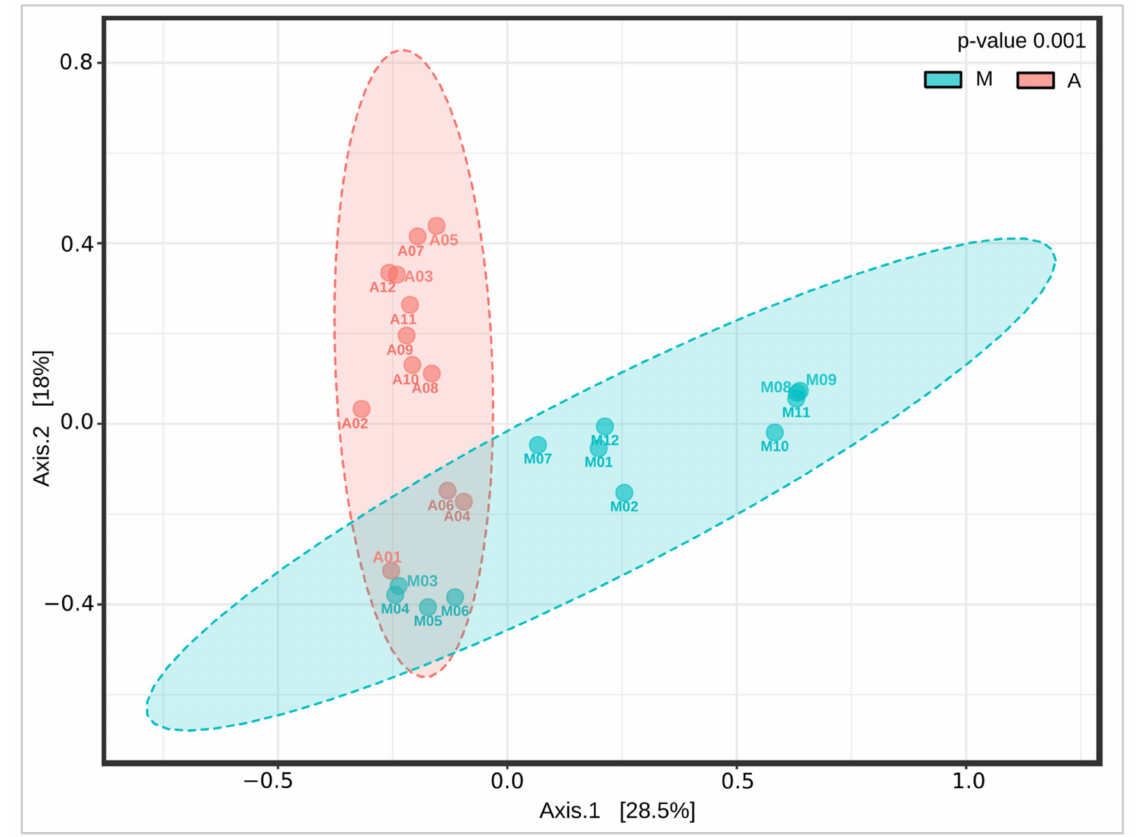
Figure 3. PCoA plot for beta diversity analysis. Samples A4, A6, A8, and A9 correspond to NLA. The remaining A samples correspond to AL. The analysis was performed using Bray–Curtis measures of beta diversity. Statistics: PERMANOVA. A: anastomosis, M: control. F-value 4.8374; R-squared 0.18025; p -value